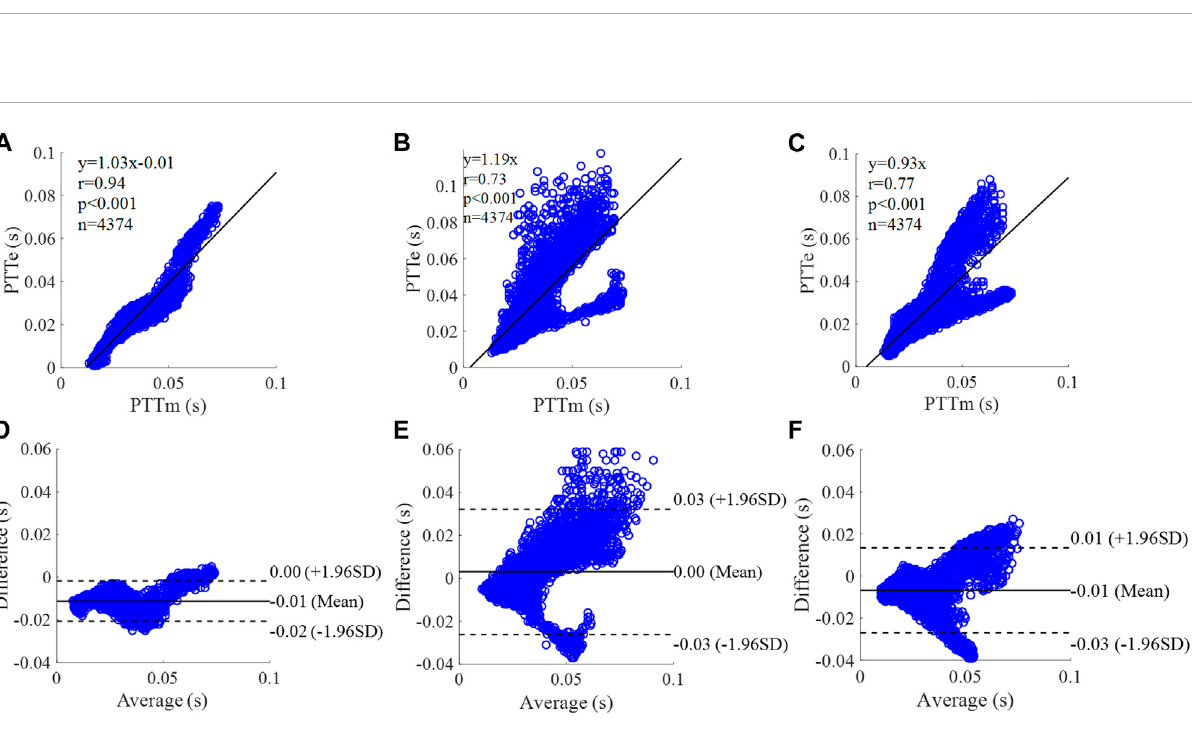
FIGURE 14 Correlation graphs and Bland-Altman plots of PTT calculated by three fl ow waveforms (A) and (D) Results of the personalized fl ow wave (Nektar1D PWDB, 4,374 subjects); (B) and (E) Results of the triangular fl ow wave (Nektar1D PWDB, 4,374 subjects); (C) and (F) Results of the lognormal fl ow wave (Nektar1D PWDB, 4,374 subjects). PTTm and PTTe are measured and estimated PTT, respectively. Difference: PTTe - PTTm; Average: (PTTe +